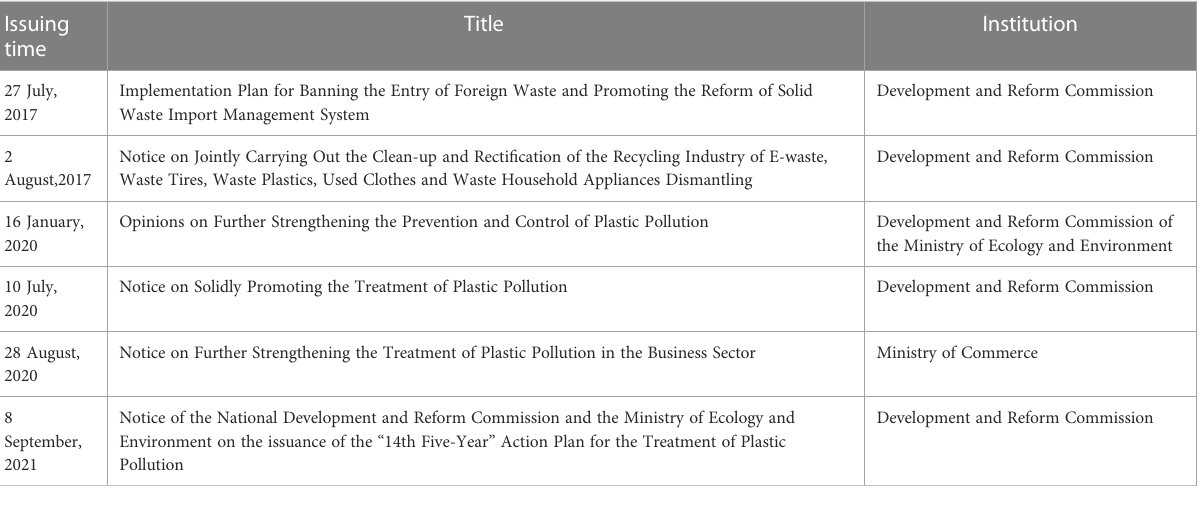
TABLE 5 Policies and governance measures related to plastic and microplastic